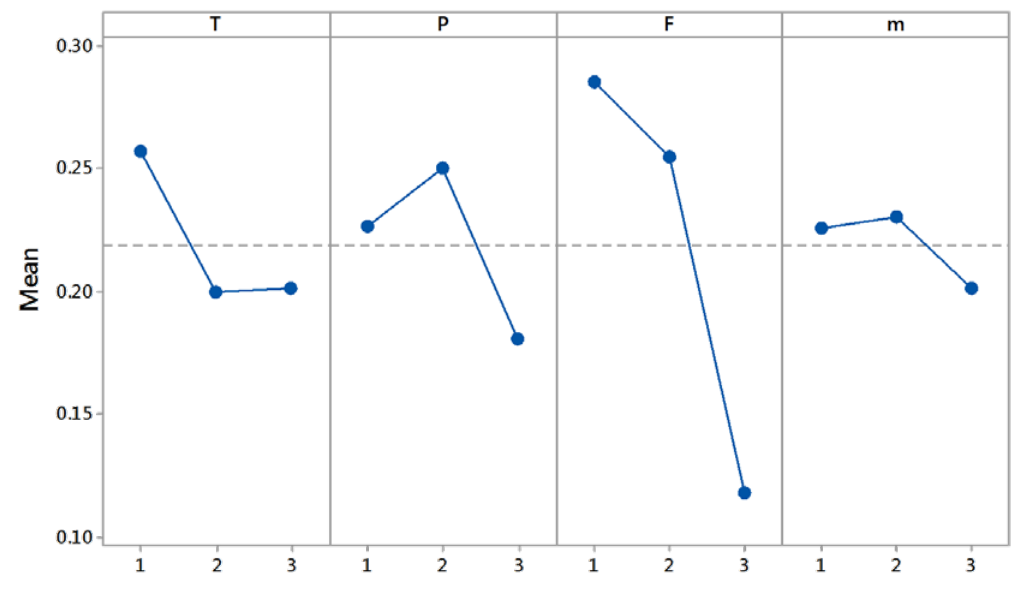
Fig. 4. Effects of process parameters on granule size distribution.